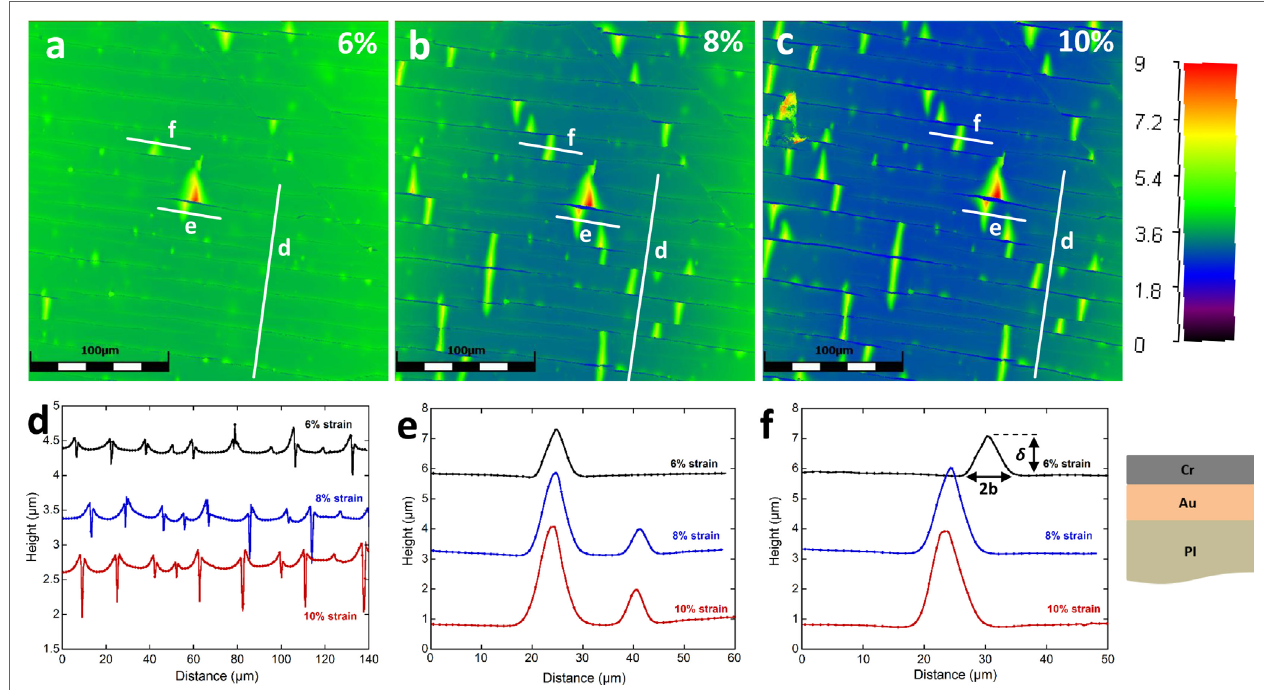
FigUre 6 | clsM color height images (color scale at right in μ m) of the 300-nm au film with 200-nm cr overlayer at (a) 6% strain, (B) 8% strain, and (c) 10% strain [scale bar in (a)–(c) is 100 μ m] . (D) Height profiles perpendicular to the cracks illustrating that the film fragments curve between the cracks. Buckle growth can also be studied with CLSM as shown in (e,F) (color